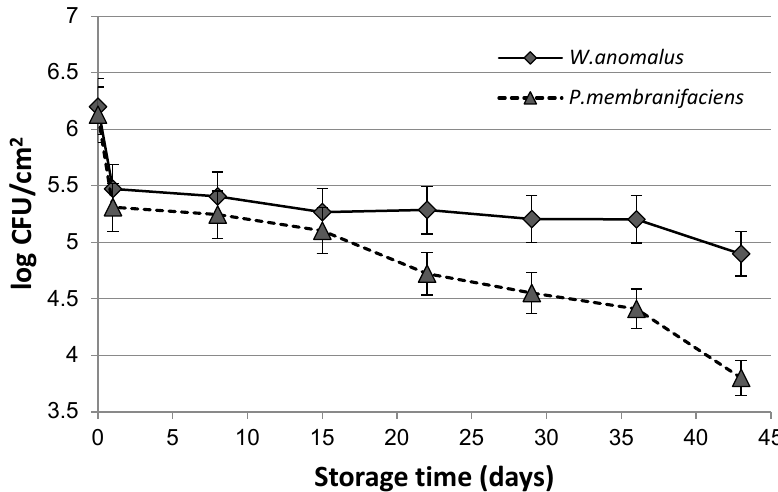
Figure 1. Changes in the population of the W. anomalus and P. membranifaciens killer yeasts entrapped in sodium alginate during storage (four weeks at 2 °C and 14 days at 22 °C).